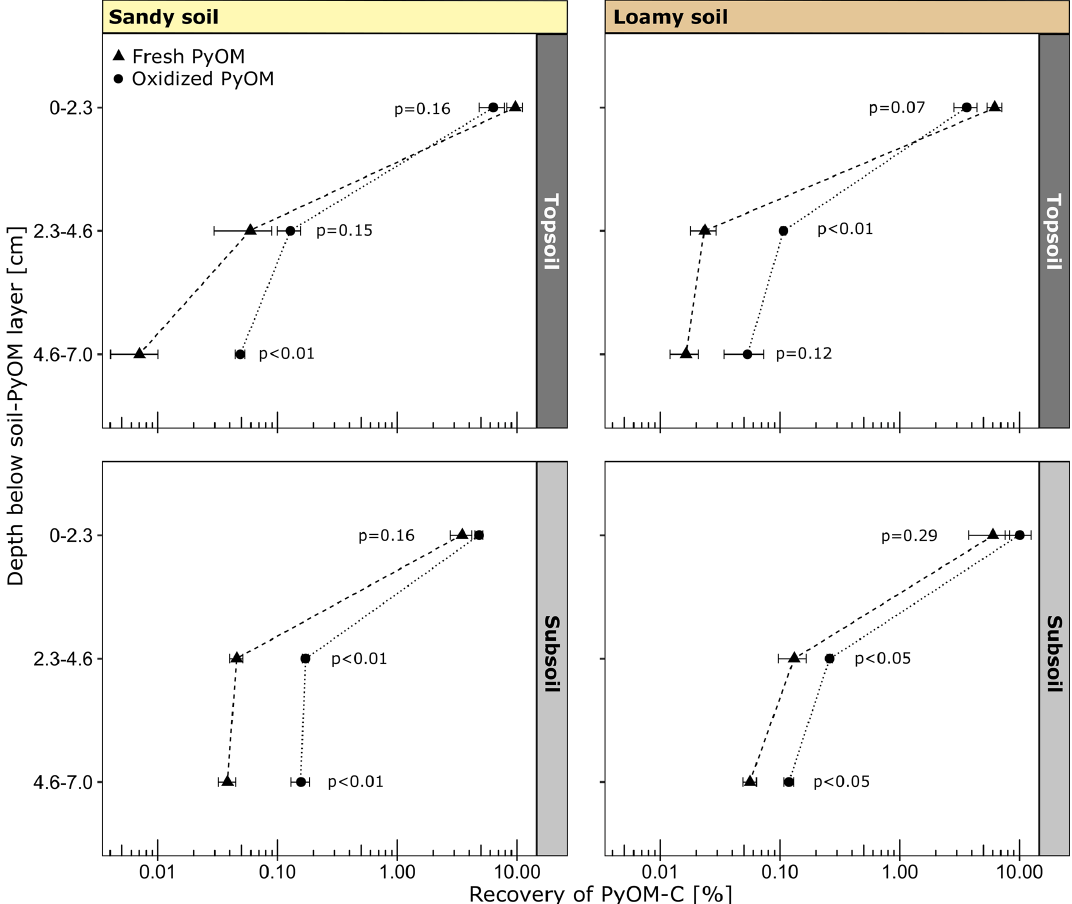
Figure 4. Recovery of PyOM-C in soil below the soil–PyOM layer of the sandy and loamy topsoil and subsoil ( ± 1SE). The p values indicate the significance of differences between fresh and oxidized PyOM at each